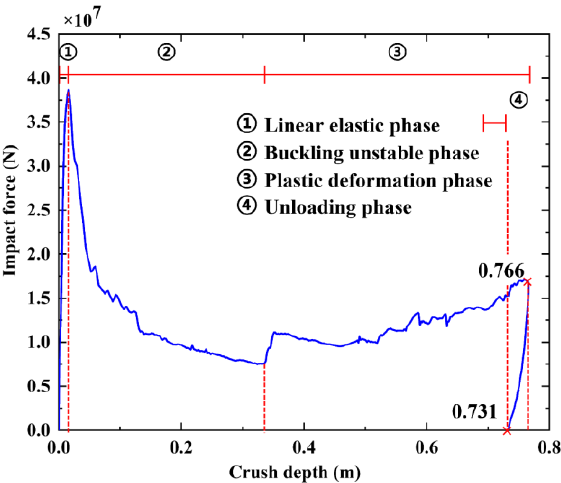
Figure 7. Relationship between impact force and crush depth in barge.